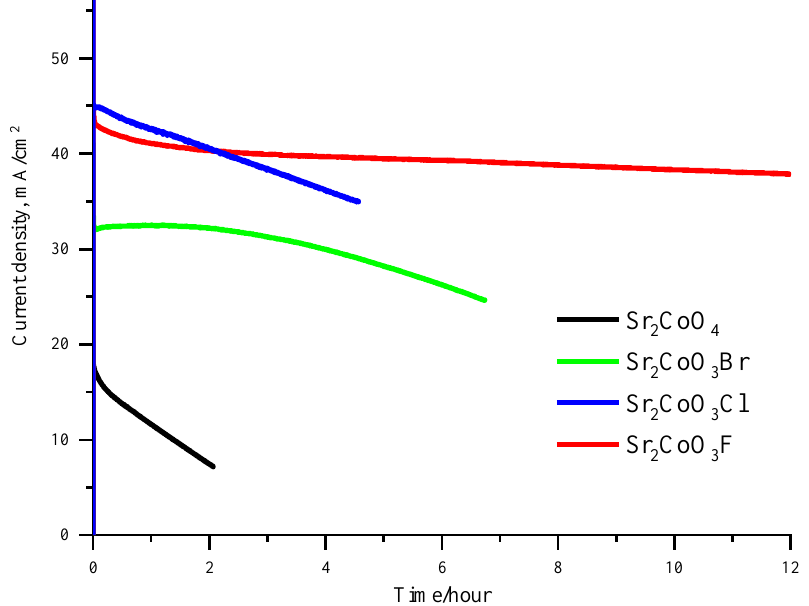
Figure 7. Chronoamperometric curves of the Sr 2 CoO 4 , Sr 2 CoO 3 F, Sr 2 CoO 3 Cl, and Sr 2 CoO 3 Br catalysts (0.8 mg/cm 2 ) in 1.0 M NaOH (pH = 14) at constant potential of 1.65 V vs. HRE. In contrast, Sr 2 CoO 3 Cl, Sr 2 CoO 3 Br, and Sr 2 CoO 4 suffer reduced activity and the current density decreased from 44.8 to 35 mA cm − 2 , 32.2 to 24.6 mA cm − 2 , and 18.3 to 7.5 mA